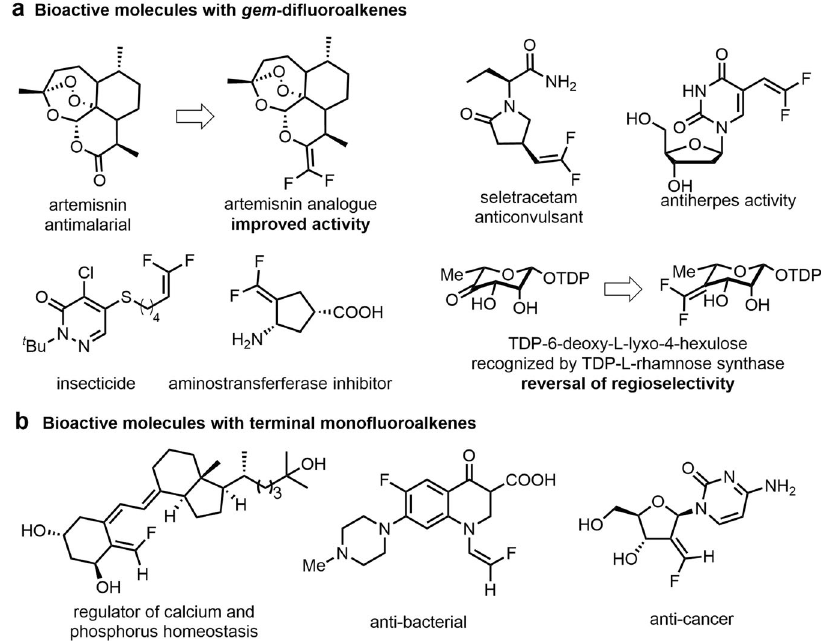
Fig. 1 Bioactive molecules with gem -di fl uoroalkene and mono fl uoroalkene moieties. a Examples of bioactive molecules with gem -di fl uoroalkene motifs. b Examples of bioactive molecules with terminal di fl uoroalkene